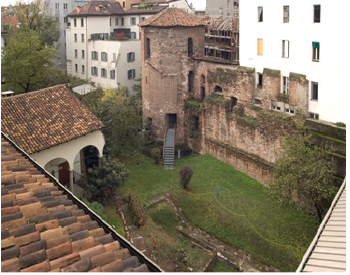
Figure 1 The archaeological remains of the Roman Circus enclose the courtyard of the Archaeological Museum in